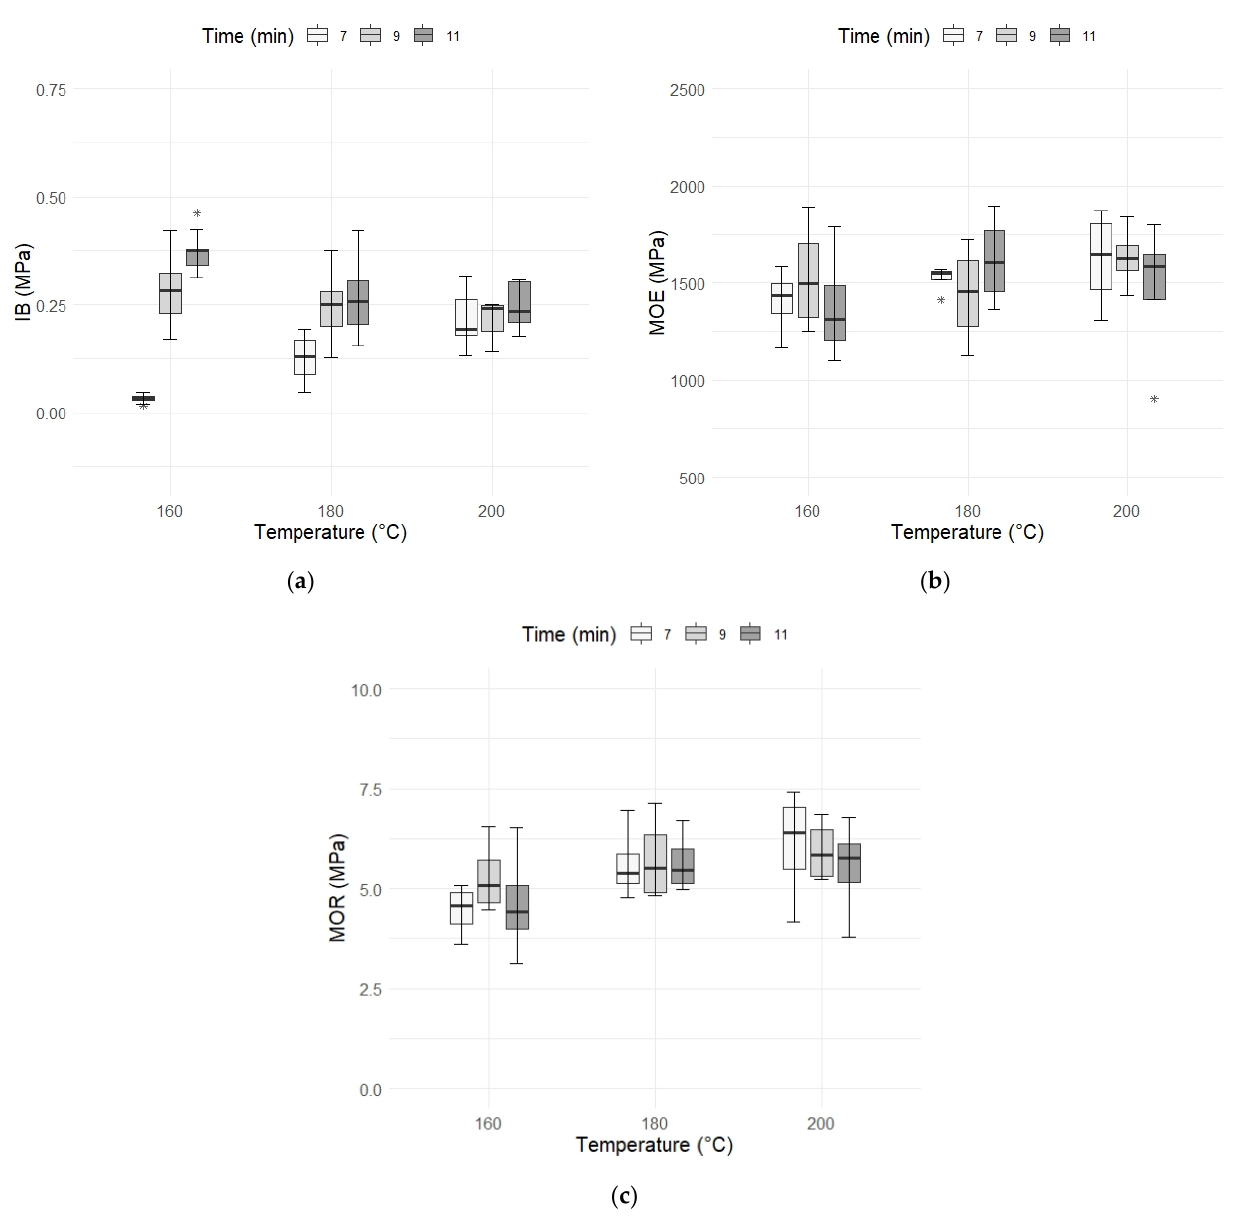
Figure 5. Influence of pressing parameter on ( a ) Internal Bond, ( b ) Modulus of elasticity, ( c ) Modulus of rupture. The whiskers represent scores outside the middle 50%, the median is represented by the line inside the box, while lower and upper quartiles are, respectively, the inferior and the bottom end of the box. Possible outsiders are indicated by asterisks.